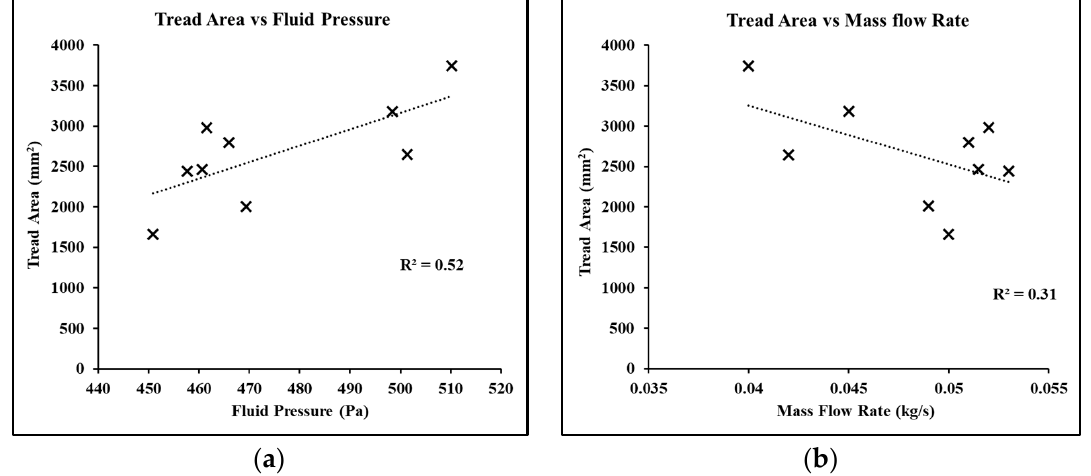
Figure 12. Effect of tread area on: ( a ) induced fluid pressure and ( b ) mass flow rate.